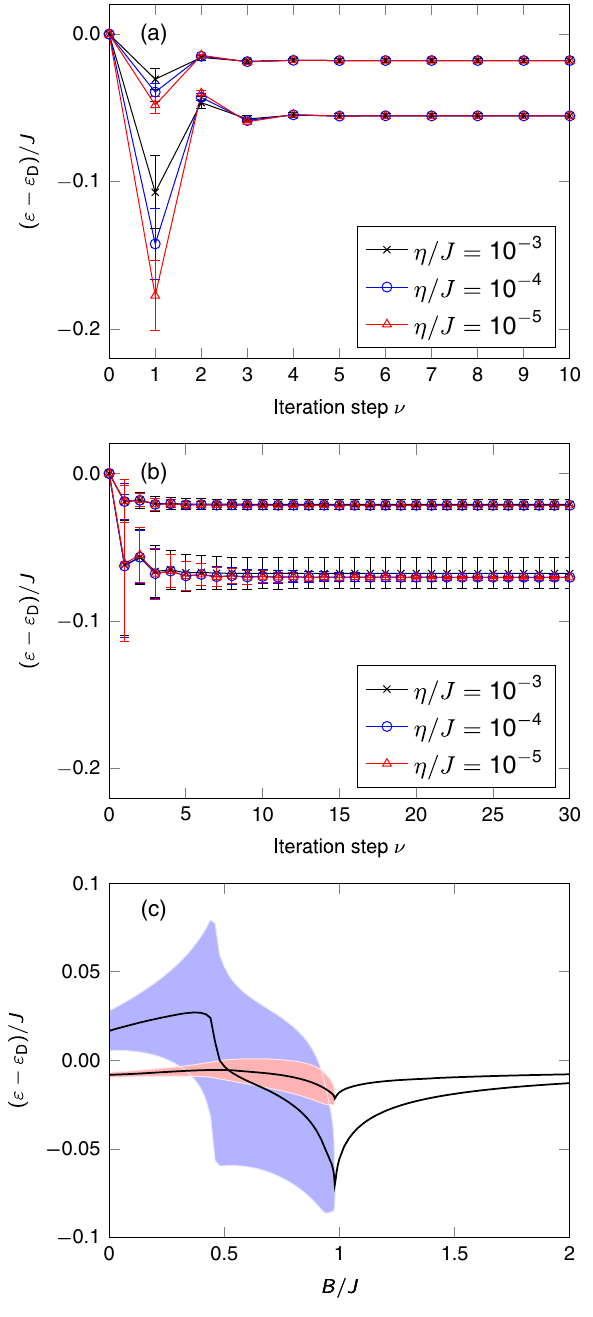
FIG. 18. Magnon spectrum of the chiral magnet at the K point within the off-shell solution of the Dyson equation. (a) Convergence behavior of the iterative off-shell solution at the singular point B ¼ B for selected values of the numerical c linewidth η . No more than ten iteration steps are necessary to obtain converged results. Error bars indicate the damping. (b) Convergence behavior at B=J ¼ 0 . 981 . About 30 iteration steps are necessary to obtain converged results for η =J ¼ 10 − 5 . (c) Magnon spectrum as a function of magnetic field B for η =J ¼ 10 − 5 . Black lines indicate the real part of the spectrum, and the colored regions indicate the linewidth (damping). The FIG. 19. DMI-induced edge twist quantified by the edge tilt parameters read S ¼ 1 and D=J ¼ 0 . 15 . angle ϑ as a function of magnetic field B and D=J